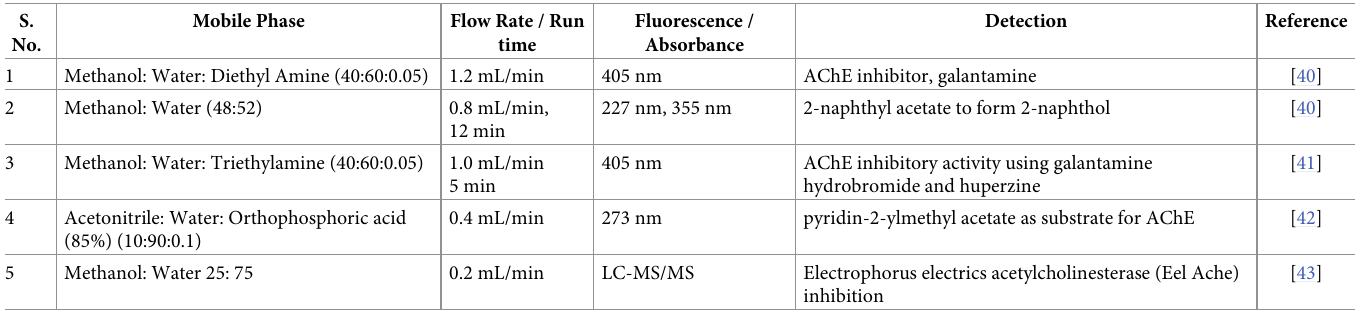
Table 1. Literature review of HPLC methods for assaying AChE activity and inhibition. S.